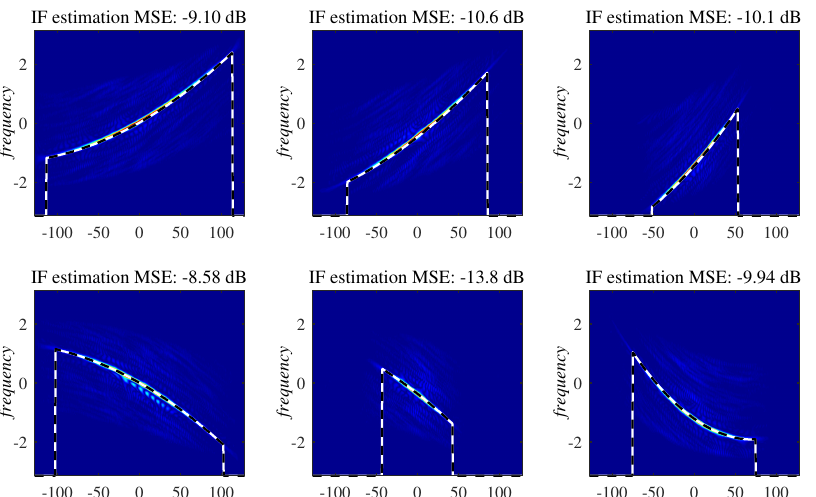
Figure 5. Instantaneous frequency estimation for individual signal components based on: extracted signal components (dashed black) and original signal components (solid white). MSEs between the two IF estimates is provided for each component of the signal from Example 1. The noise variance is σ 2 ε = 1. Decomposition is based on C = 128